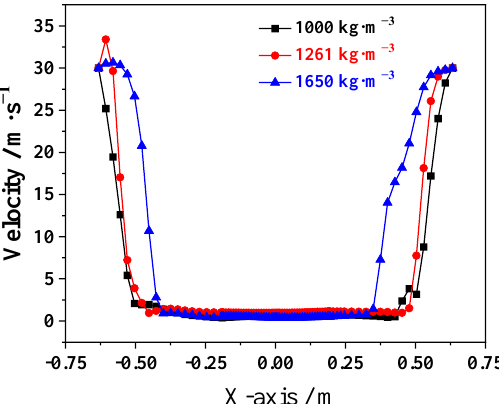
Figure 8. Velocity distribution in the x -axis direction under different liquid densities (inlet velocity: 30 m/s, viscosity: 0.0055 Pa·s).